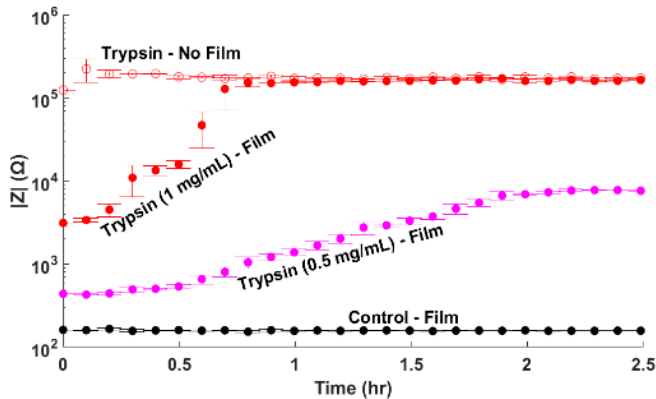
Figure 3. Representative impedance responses at 10 kHz of sensors, either uncoated or coated with a gelatin film, to trypsin at 1 (both film and no film), 0.5 (film only) and 0 mg/mL in phosphate-buffered saline (Control). The error bars plot the temporal change in impedance at respective time points (span = 3).